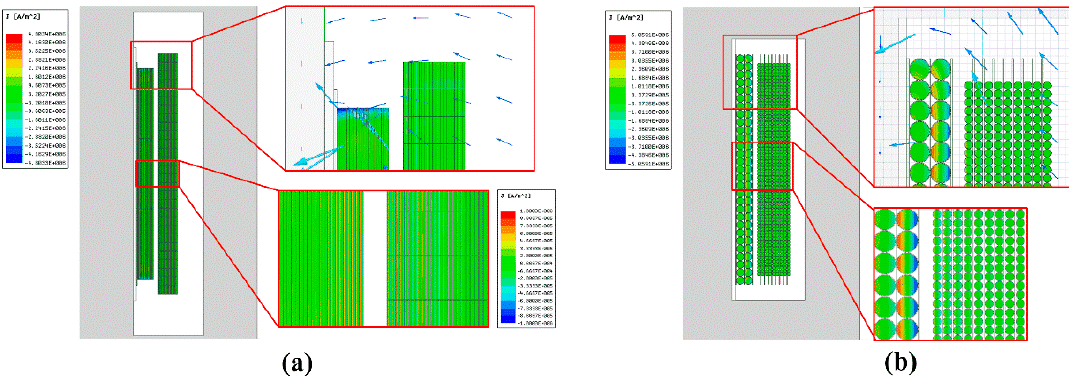
Figure 6. Magnetic field and current density distribution from finite element modelling-computational fluid dynamics (FEM-CFD) approach: ( a ) prototype 1; and, ( b ) prototype 2.